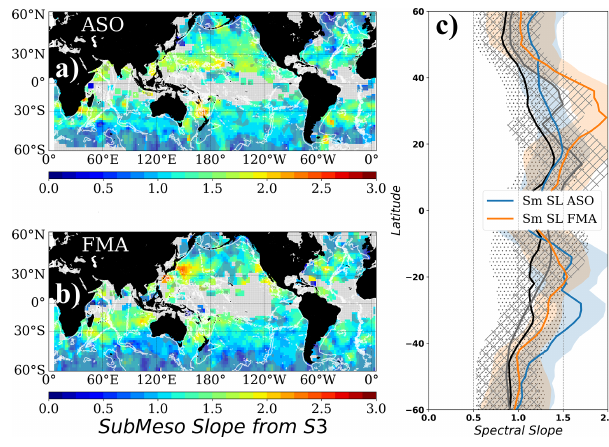
Figure B2. Small-scale spectral slope averaged during (a) August– September–October and (b) February–March–April for Sentinel-3. Gray shading in (a) and (b) corresponds to zones where the uncer- tainty associated with the slope estimate is higher than 40% of the slope value. Blank areas in (a) and (b) correspond to zones where the double-slope model does not describe the observed shape of the spectrum. (c) Zonal averages of the valid pixels in (a) and (b) . ASO (black line, dotted shading) and FMA (gray line, hatched shading) zonal averages for Jason-3 are also plotted in (c) . White contours in (a) and (b) represent the topography at 3000m depth. lation in the equatorial band (10 ◦ S–10 ◦ N), where the sea- sonal changes in stratification are rather limited.